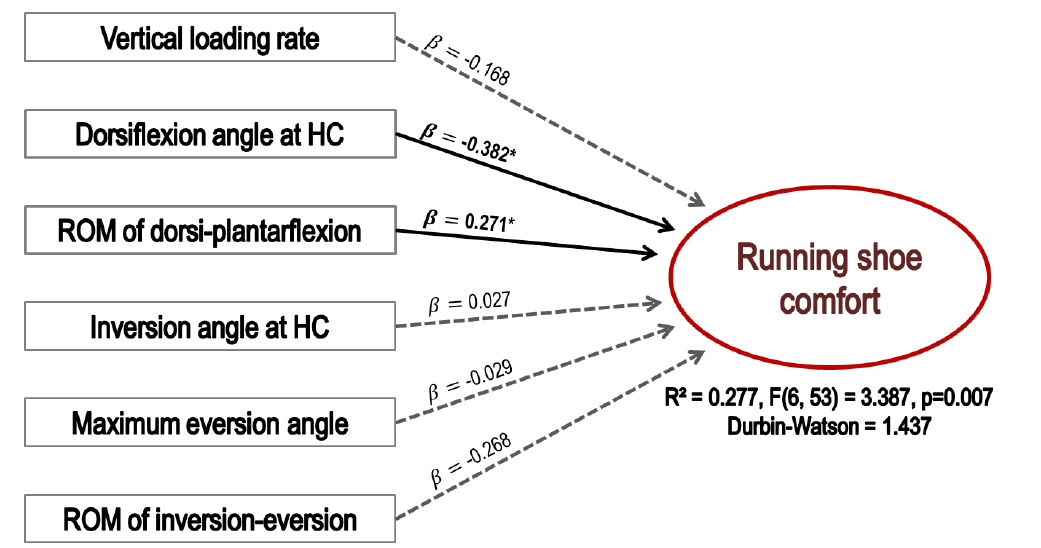
Figure 5. Diagram of multiple regression analysis for running shoe comfort using biomechanical factors. * indicates a significant difference between the shoes at α = 0.05.